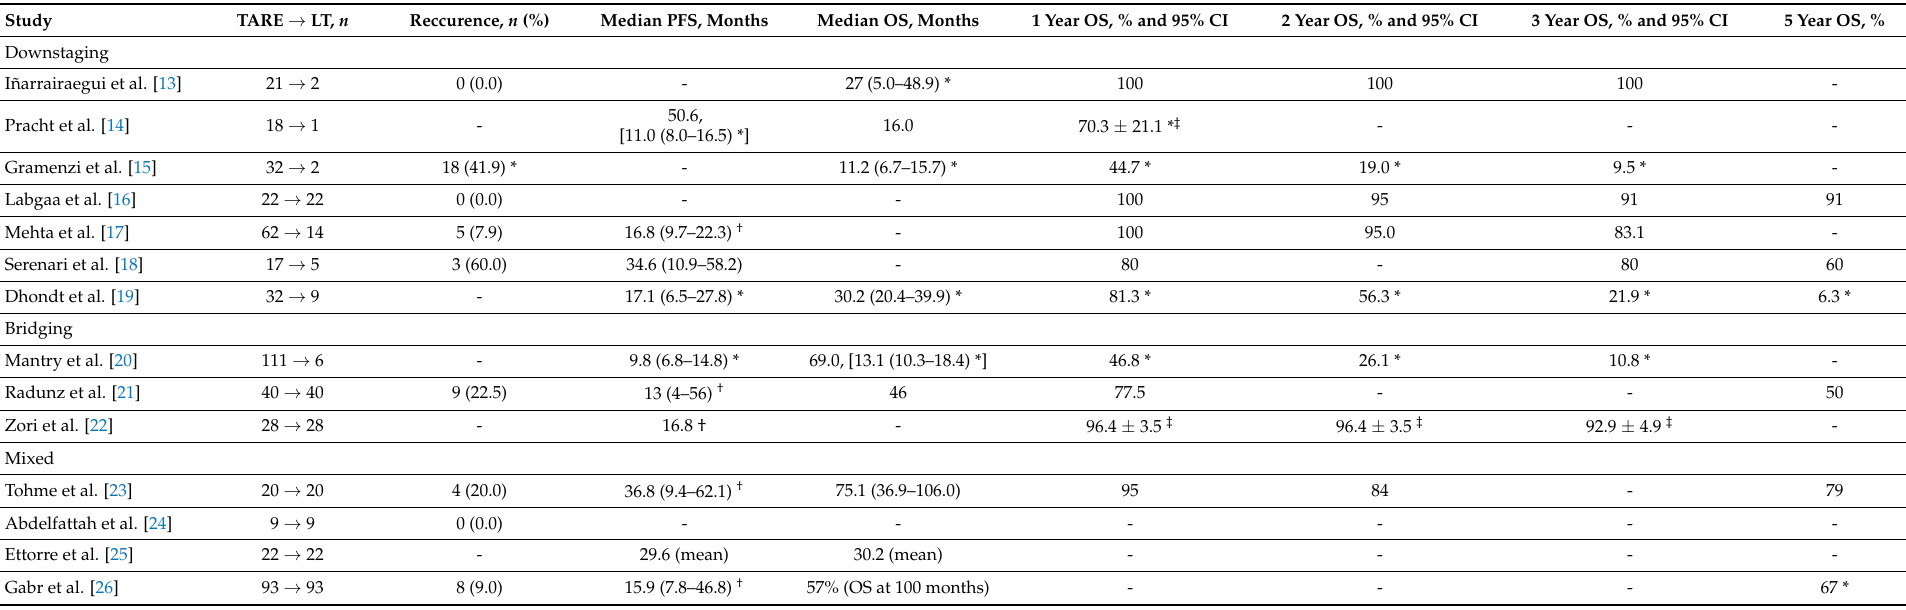
Table 2. Oncological outcomes after LT following